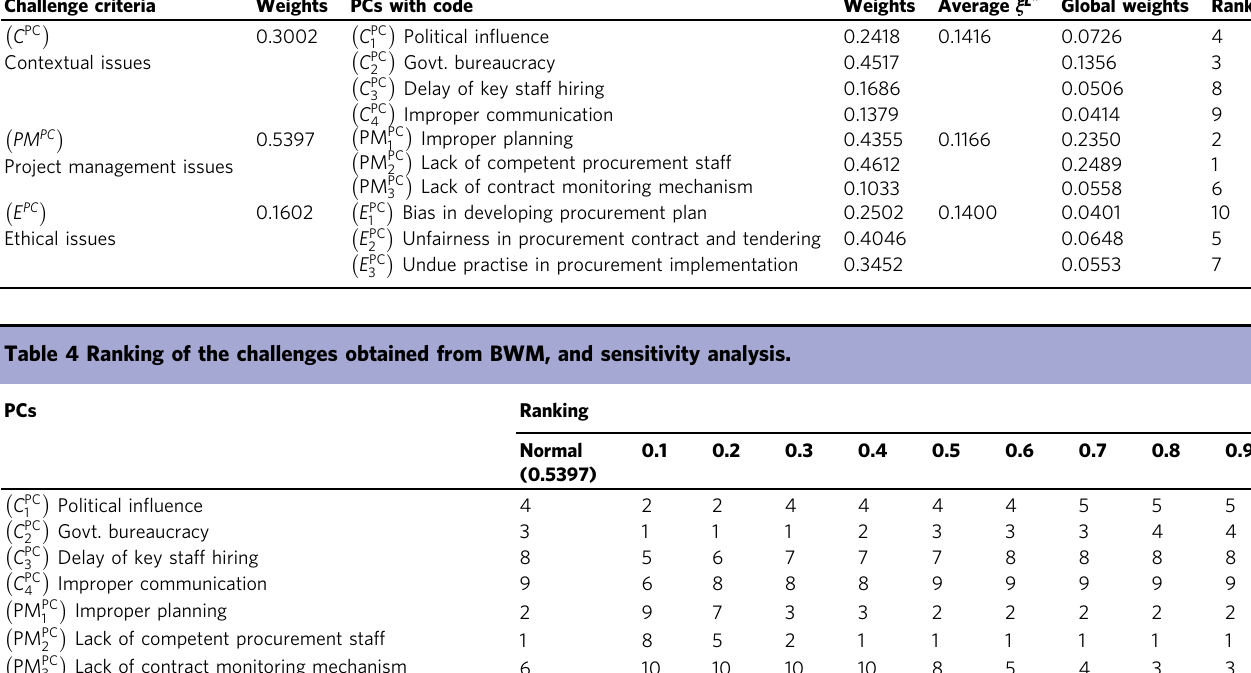
Table 3 Weights and ranking of the PCs obtained via BWM. Challenge criteria